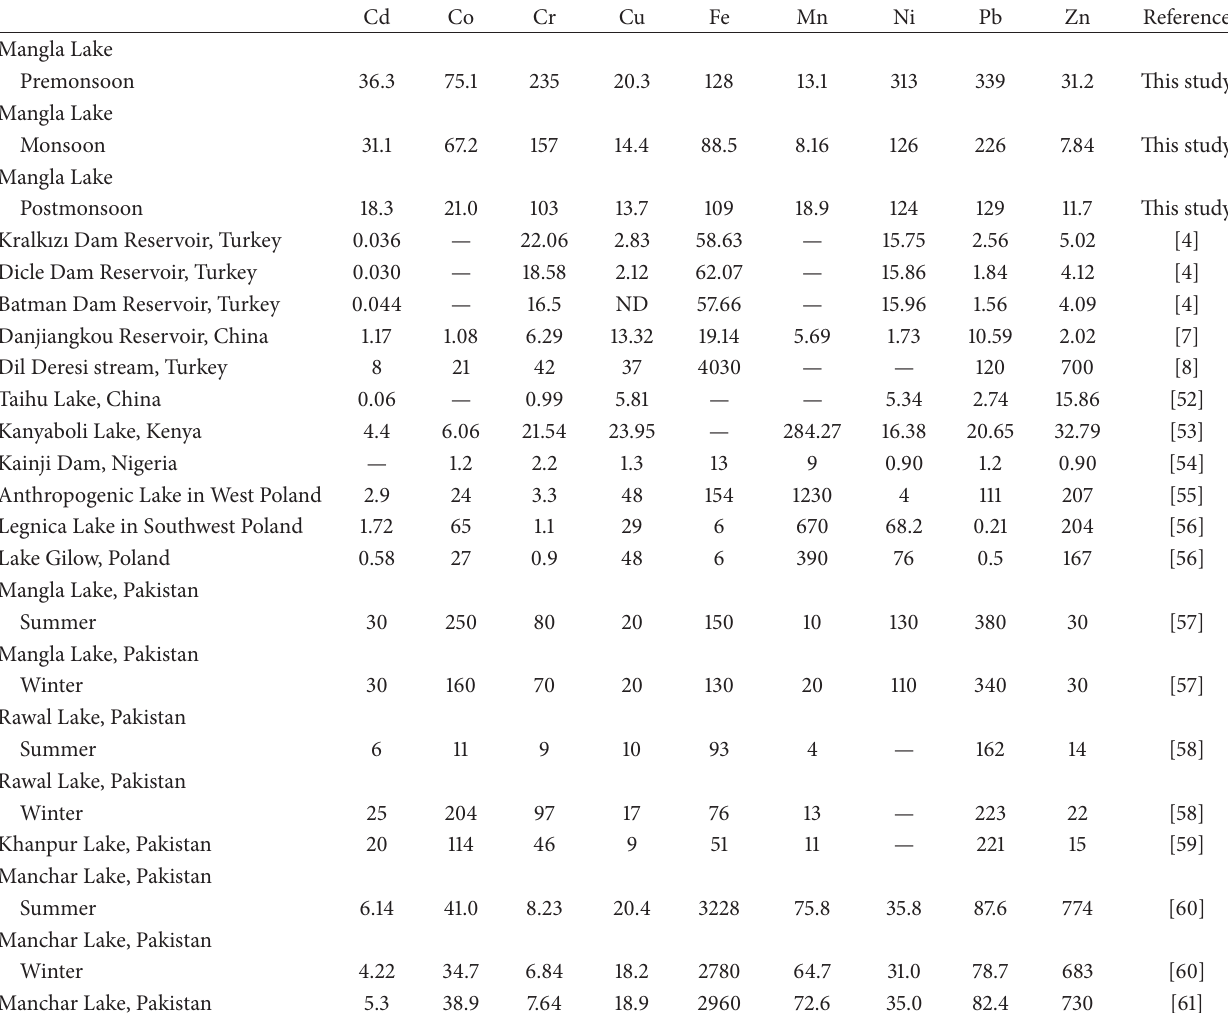
Table 3: Comparison of mean trace metals concentrations ( 𝜇 g/L) in surface water of Mangla Lake with national and international studies. Cd Co Cr Cu Fe